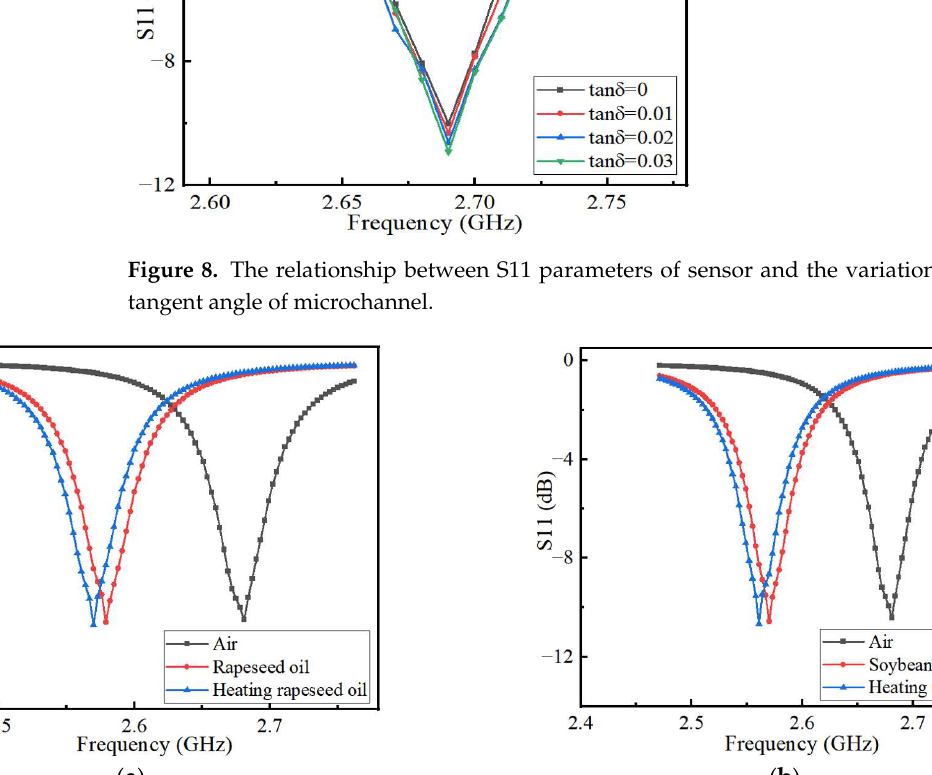
Figure 8. The relationship between S11 parameters of sensor and the variation of dielectric loss tan- gent angle of microchannel.